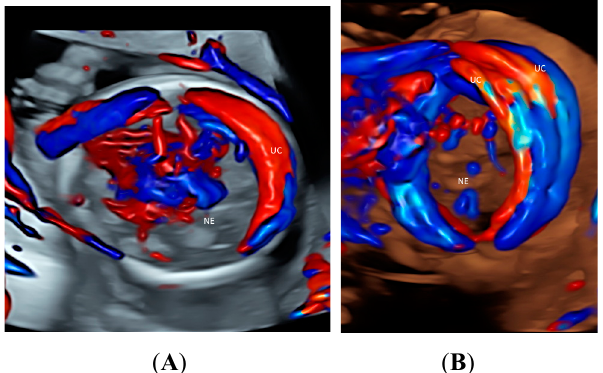
Figure 8. Glass-body rendering mode with color Doppler showing nuchal cord with umbilical cord (UC) wrapping around the neck (NE) once in a fetus ( A ) and twice in a fetus ( B ), both at 20 weeks’ gestation.